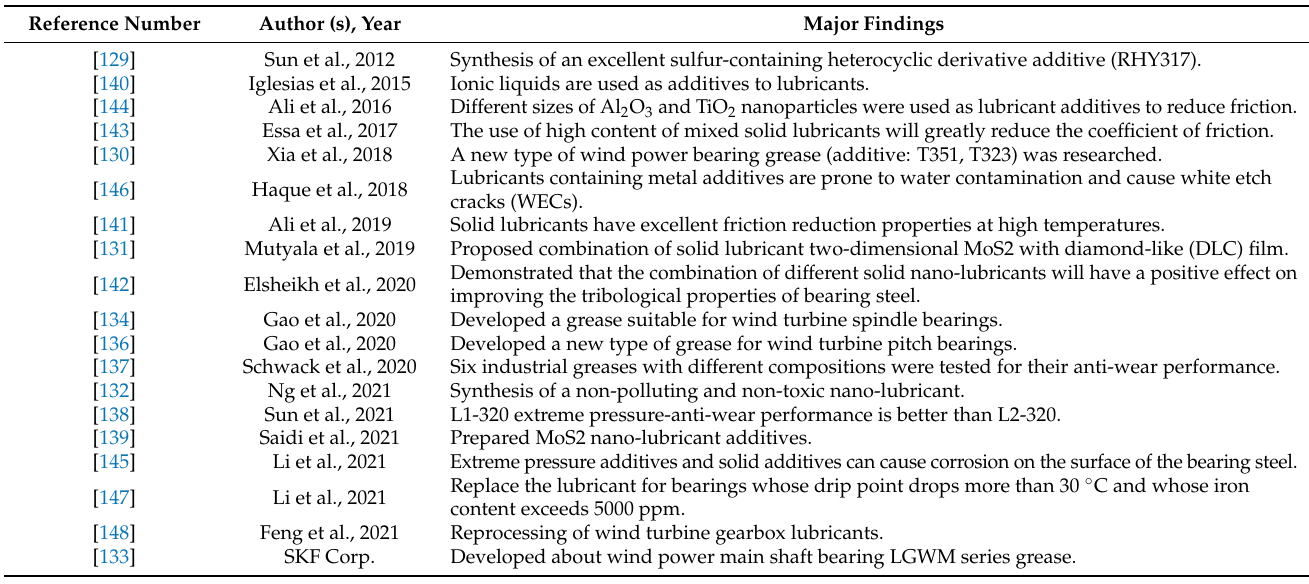
Table 5. Summary of the current status of wind power bearing lubricant